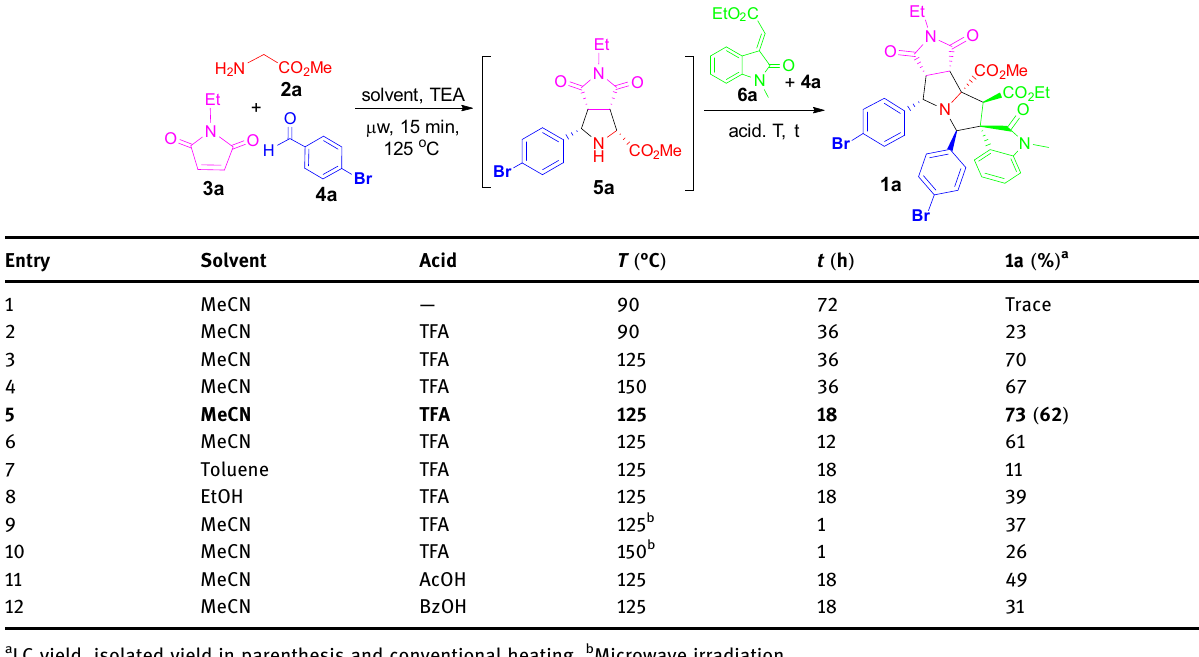
Table 1: Double [ 3 + 2 ] cycloaddition conditions for 1a